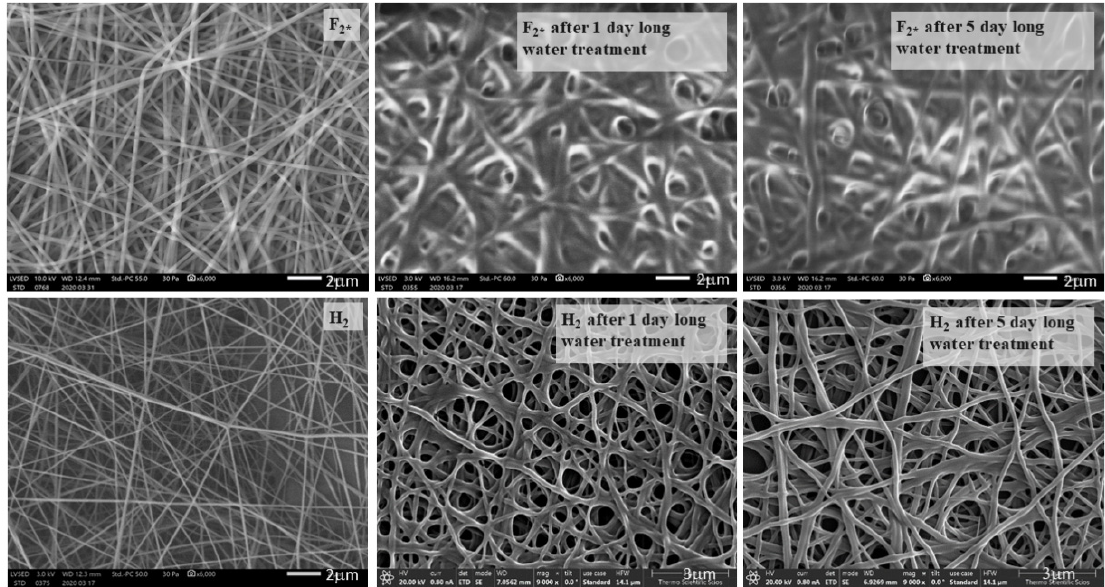
Figure 8. Scanning electron microscopy images of air-dried F 2* and H 2 samples immersed in water for 1–5 days, taken at 6000× and 9000× resolution, with 2 μ m scale, and 3 μ m in the case of H 2 samples after water treatment.